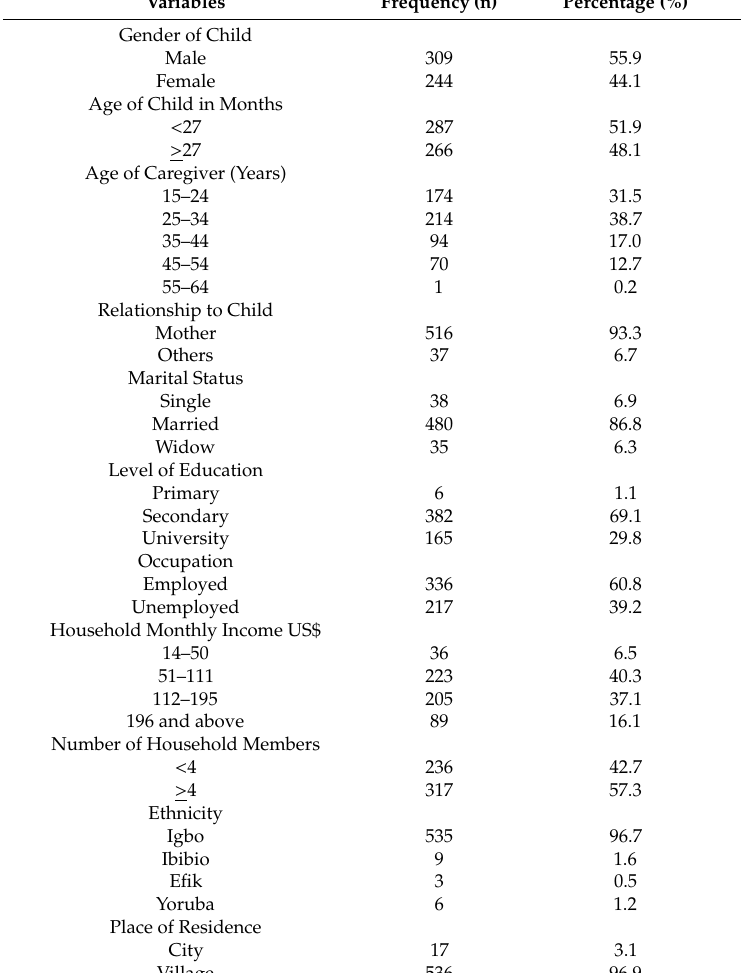
Table 1. Socio-demographic characteristics of respondents (N =